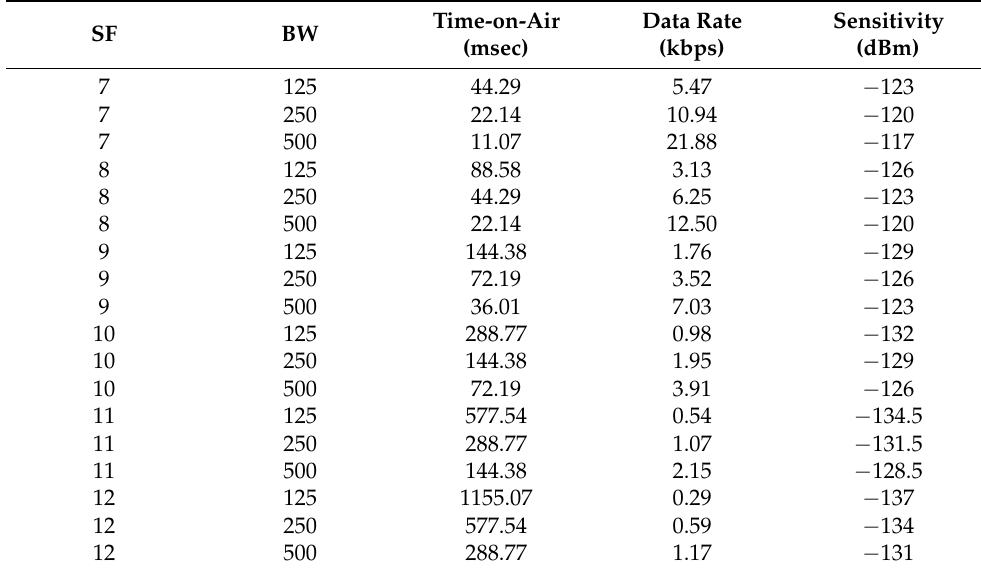
Table 1. Main transmission features for the different Spreading Factors (SFs) and Bandwidths (BWs). SF